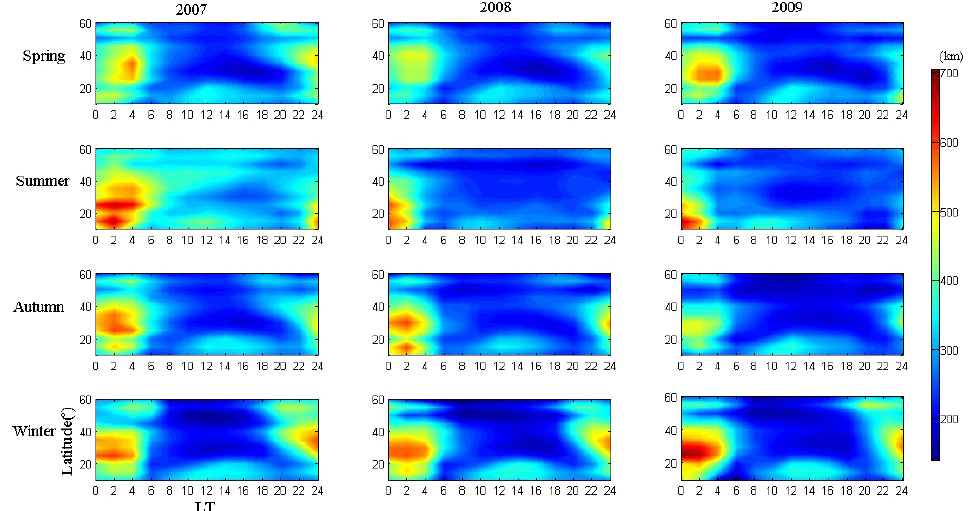
Figure 4. Latitudinal, diurnal and seasonal variation in slab thickness during the low-solar-activity period of 2007–2009.